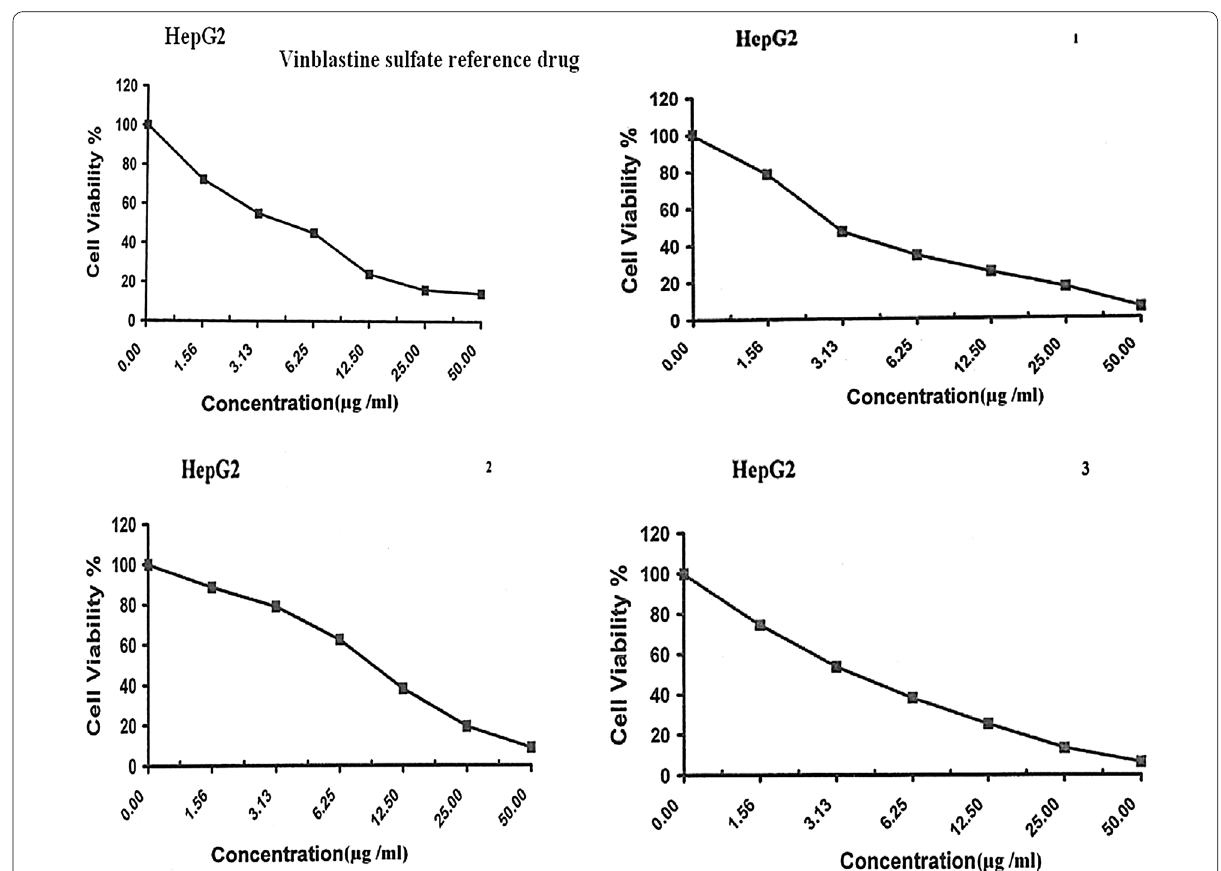
Fig. 2 Viability values of quinazoline derivatives 1 – 3 and Vinblastine sulfate against HepG2 cell line